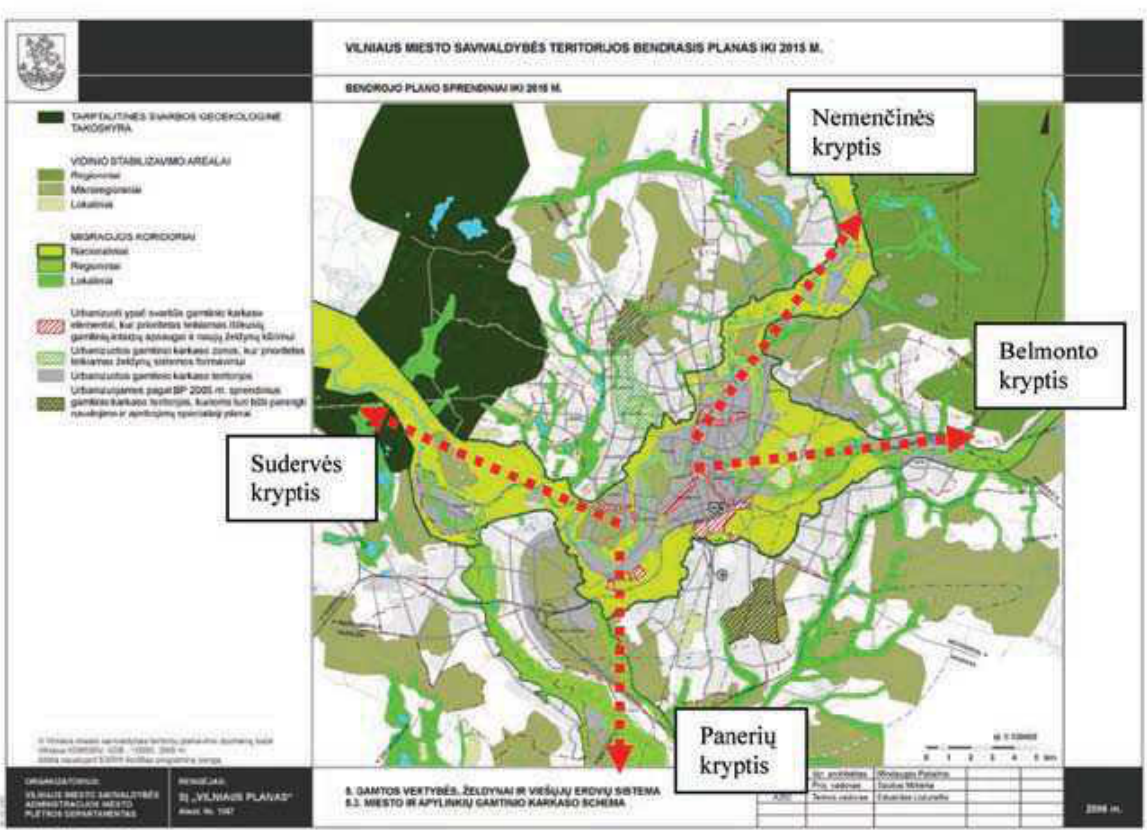
Fig. 2. Main natural axes marked in the Master Plan of Vilnius city (2006) are selected as priority directions for developing recreational links between urban and suburban